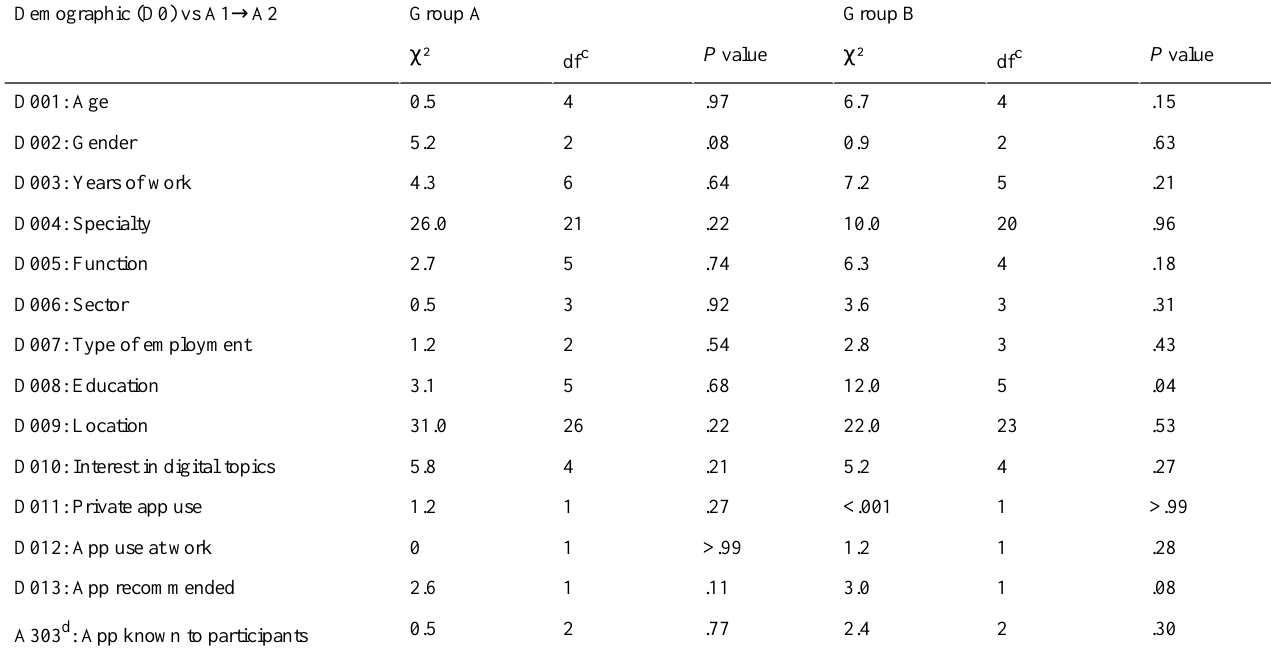
Table 12. Demographic factors versus changes in assessment: initial to intermediate assessment (ie, changes from A1 a to A2 b toward a more critical